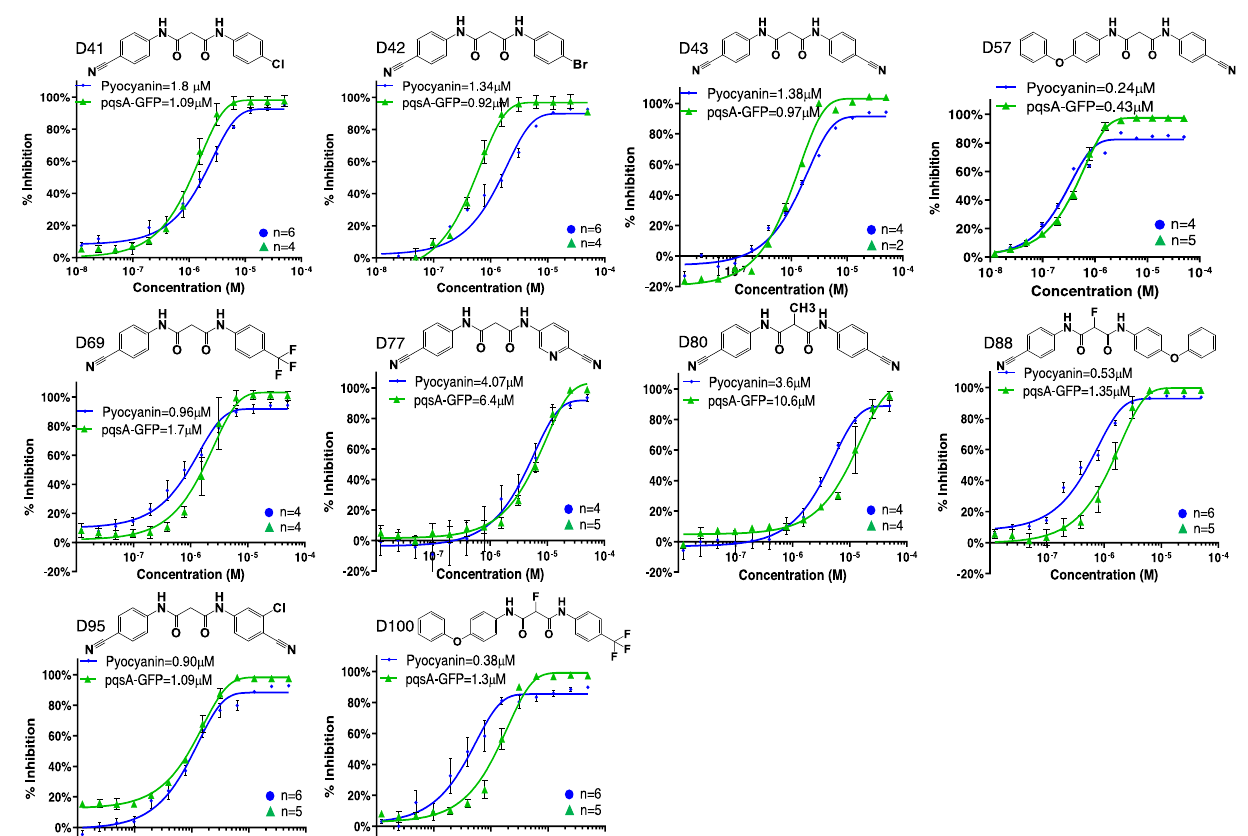
Fig. 2 | Dose-dependent inhibition of pyocyanin production and PqsA-GFP expression. IC 50 determination was performed in the presence and absence of each of the 10 NAM compounds at 13 different concentrations ranging from 0.01 – 50 µ M. Graphs are showing IC 50 values for pyocyanin (blue) and PqsA-GFP (green) for D41, D42, D43, D57, D69, D77, D80, D88, D95, D100. IC 50 curves were plotted as a percentage of pyocyanin production and pqsA-GFP expression of the